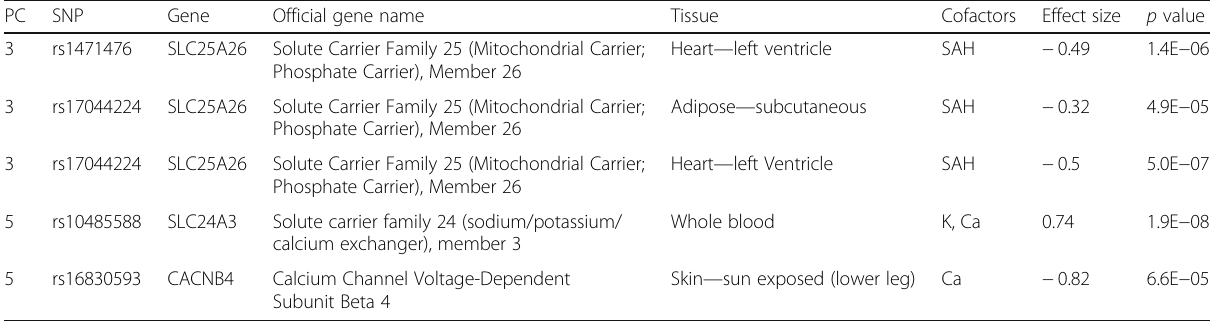
Table 2 Significant eQTL from positively selected cofactor transporter SNPs PC SNP